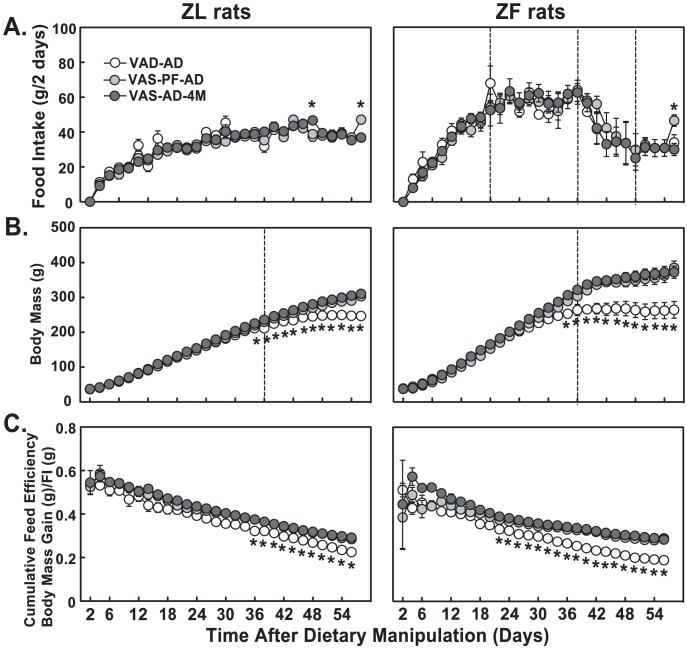
The food intake, body mass and cumulative feed efficiency over 56 days of dietary manipulation.(A) Two-day food intake of ZL and ZF on VAD ad libitum (VAD-AD, n = 5), VAS-Pair-feeding Last Day ad libitum (VAS-PF-AD, n = 5), VAS-Pair-feeding Last Day 4 meals (VAS-PF-4M, n = 5) (B) Body mass of ZL and ZF on VAD AD, VAS-PF AD and VAS-PF 4M. (C) Cumulative feed efficiency (unit weight gain per unit diet consumed) of ZL and ZF on VAD-AD, VAS-PF-AD and VAS-PF-4M. * Indicates p<0.05 using one-way ANOVA with LSD post-hoc test.